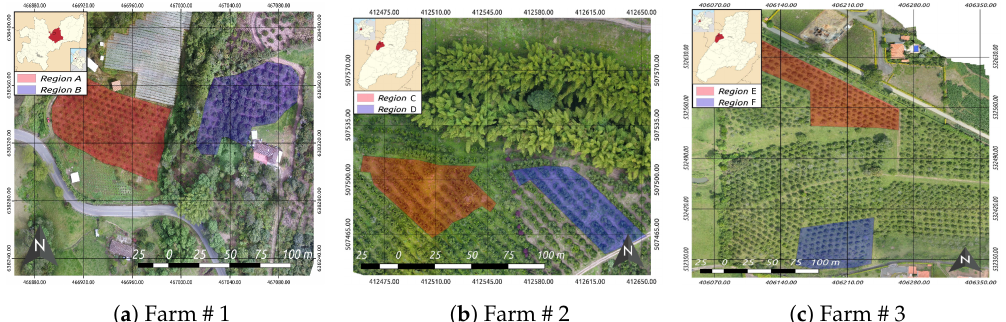
Figure 1. Tested Colombian orchard fields. Scenes and crop locations of evaluated trees: citrus (shaded in red color) and avocado (shaded in blue). Table 1. Flight unmanned aerial vehicles (UAV) parameters employed for collecting aerial data from the tested orchard farms.